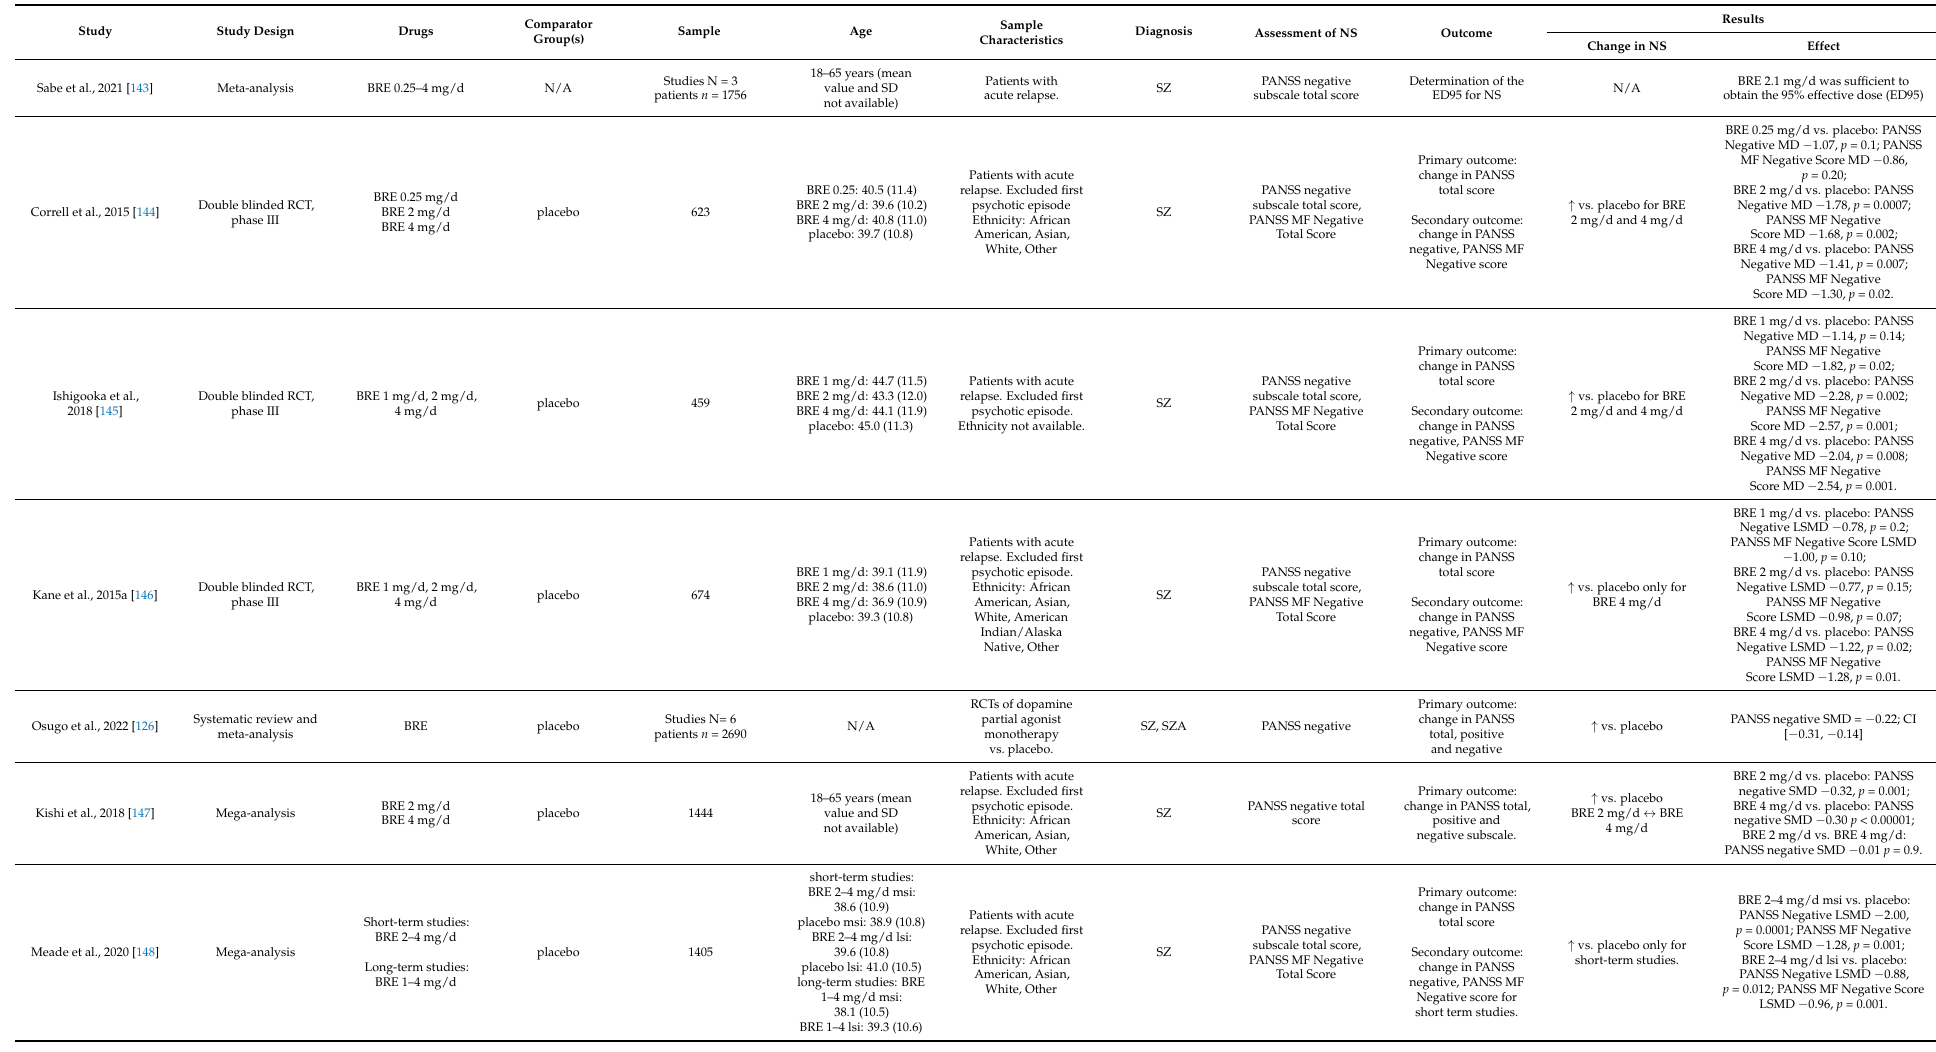
Table 3. Studies on the efficacy of brexpiprazole in the treatment of negative symptoms.